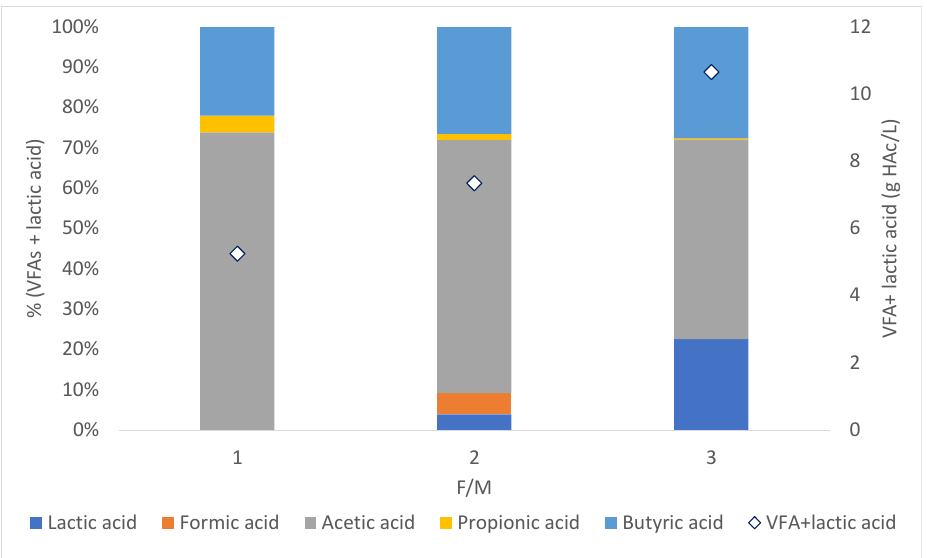
Figure 6. Total VFA + lactic acid concentration (mg HAc/L) and percentage after the dark fermentation of the winter/autumn fruit and vegetable waste mixture under the three different S/I conditions investigated.